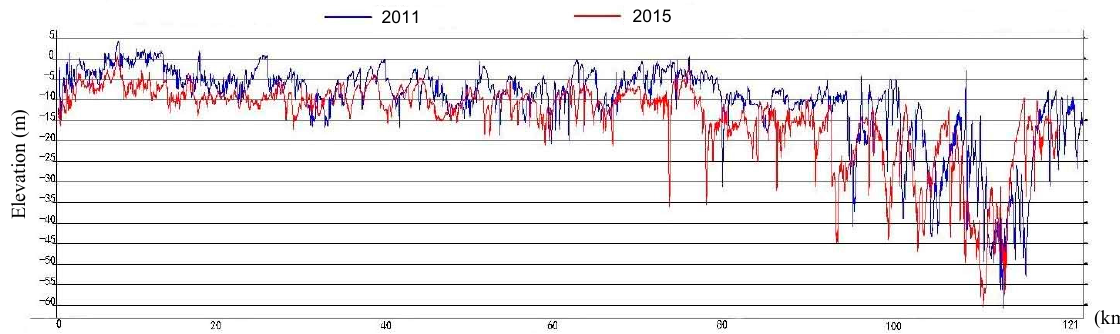
Figure 9. Comparison of thalwegs of the lower Min River (start from the Shuikou Dam to the river mouth) in 2011 and 2015.